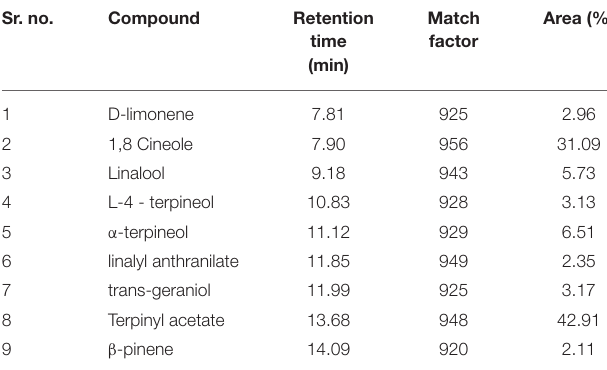
TABLE 1 | Phytochemical composition of cardamom oil by